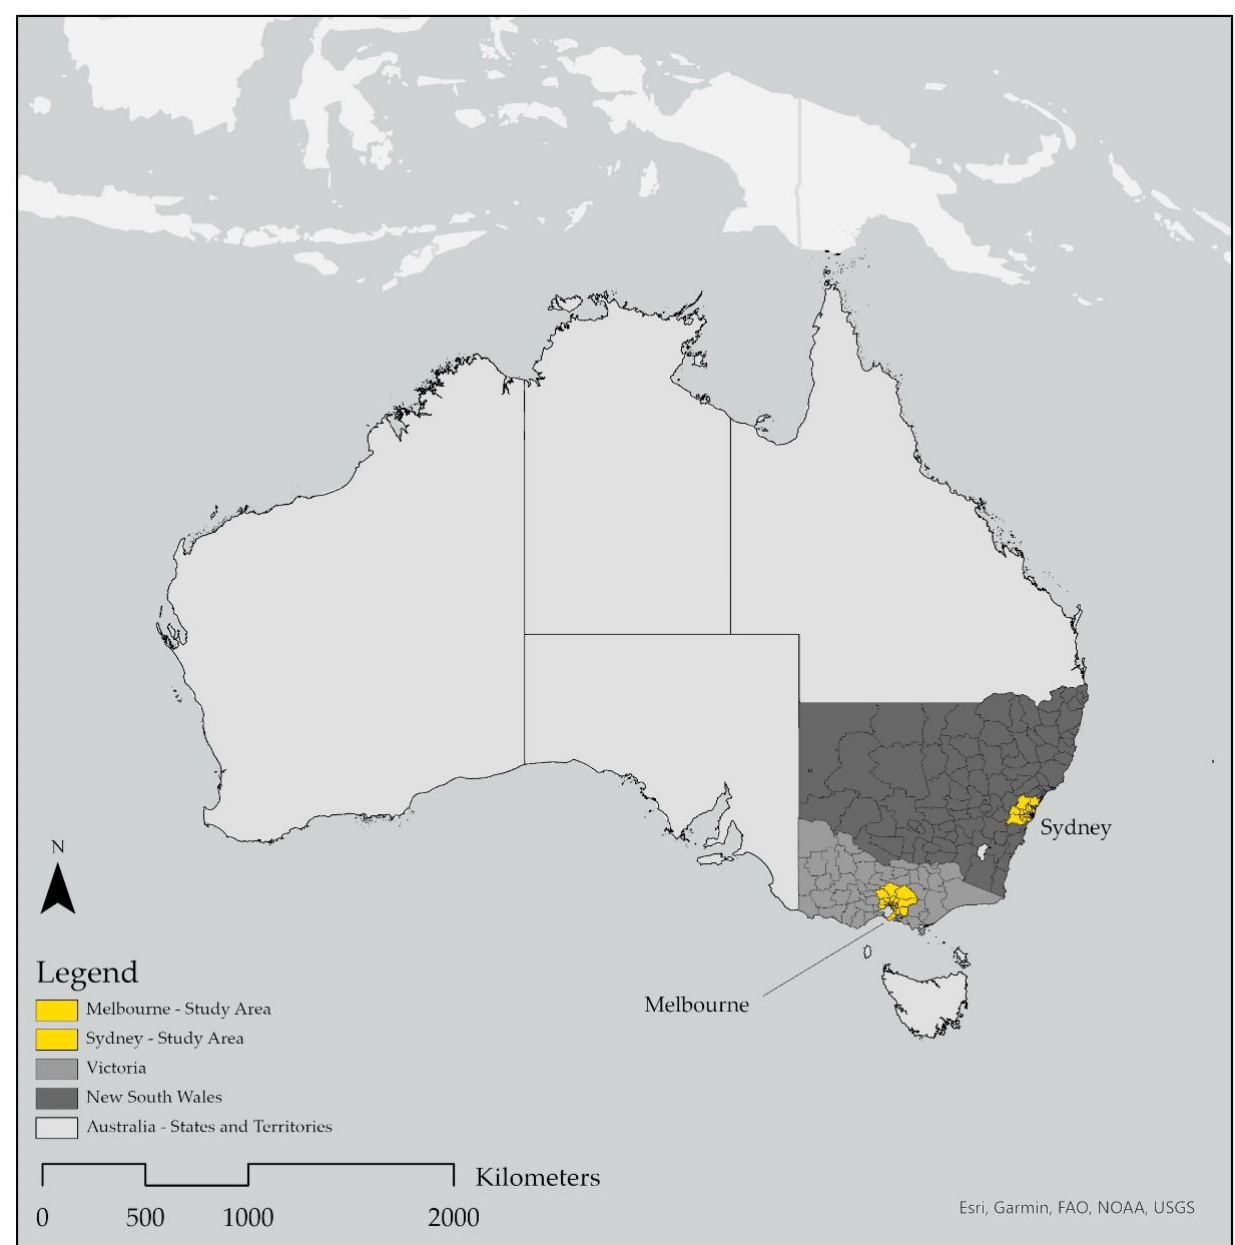
Figure 4. This study covers Australia’s two largest cities, Sydney and Melbourne, which both experienced outbreaks of the Delta Variant in 2021.